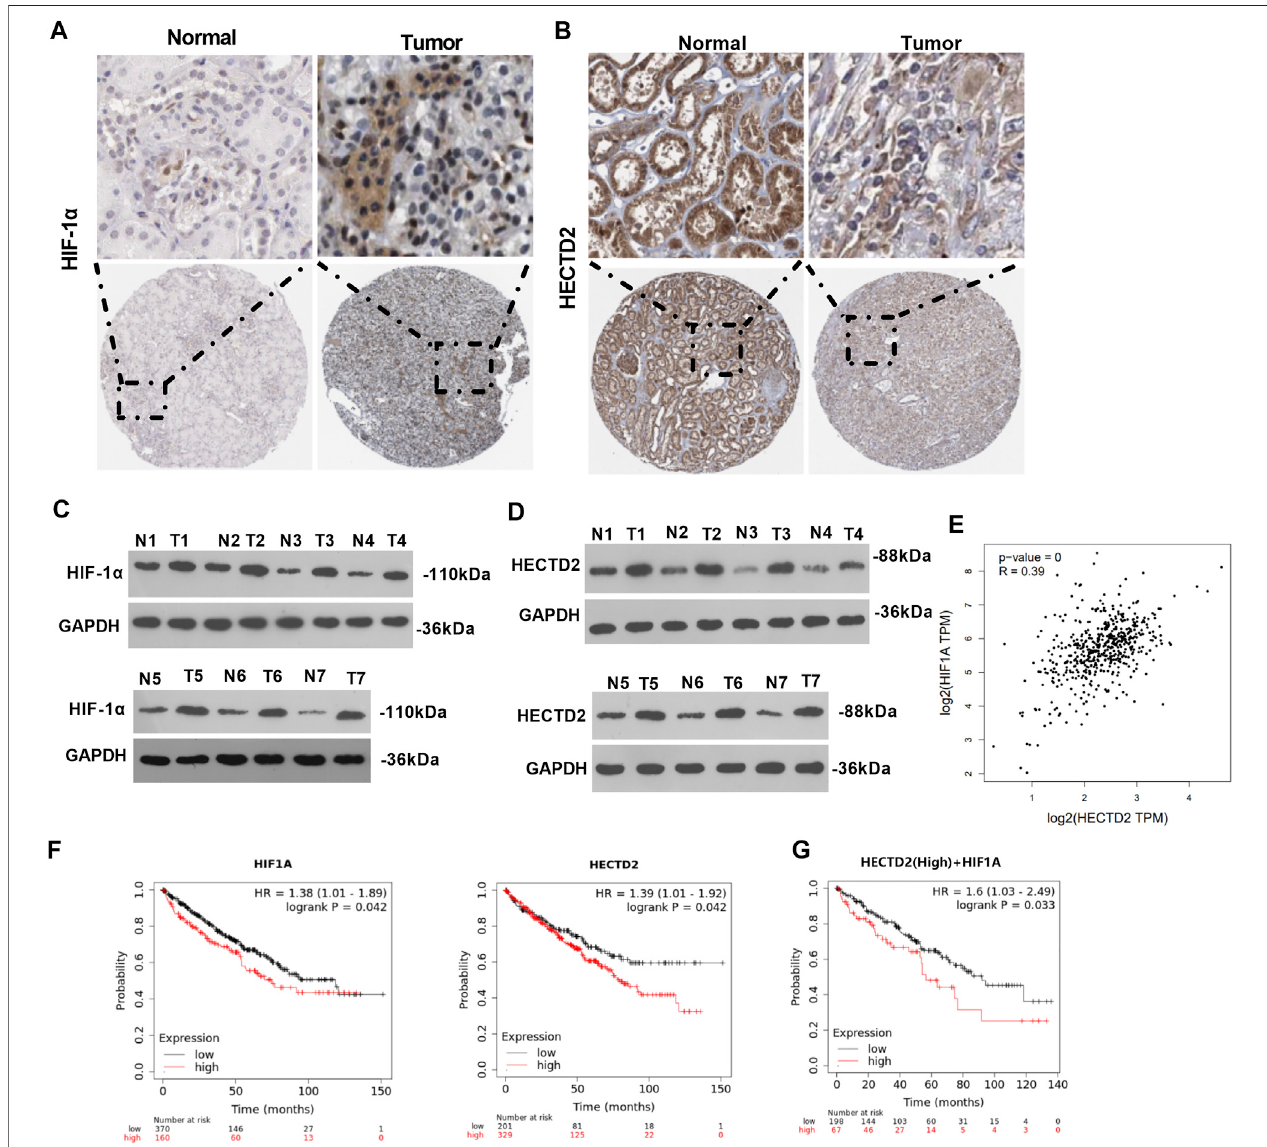
FIGURE 1 | Expression and prognosis of HIF-1 α and HECTD2 in RCC (A,B) . The number of HIF-1 α and HECTD2 positive cells in RCC tissue and normal paracanceroustissueswasanalyzedintheHumanProteinAtlasdatabase(https://www.proteinatlas.org/). (C,D) :HIF-1 α andHECTD2proteinpro fi lesin7casesofRCC tissues (T) and normal paracancerous tissues (N) were compared by WB. (E) The online database GEPIA was used for analyzing the expression relationship in KIRC (http://gepia.cancer-pku.cn/). (F,G) : Prognostic analysis of HIF-1 α and HECTD2 in RCC was performed on Kaplan-Meier Plotter (http://kmplot.com/analysis/).